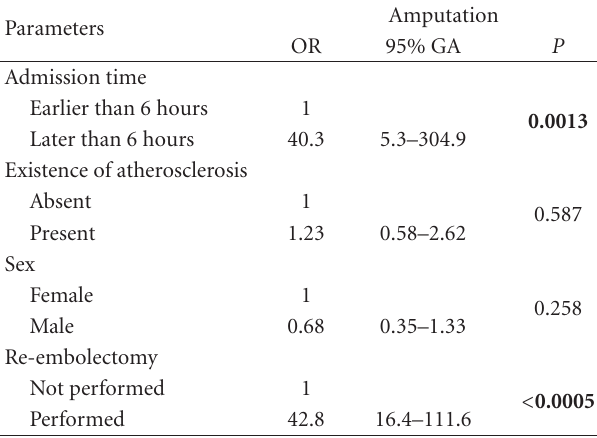
Table 2: E ff ective factors on amputation (results of logistic regression